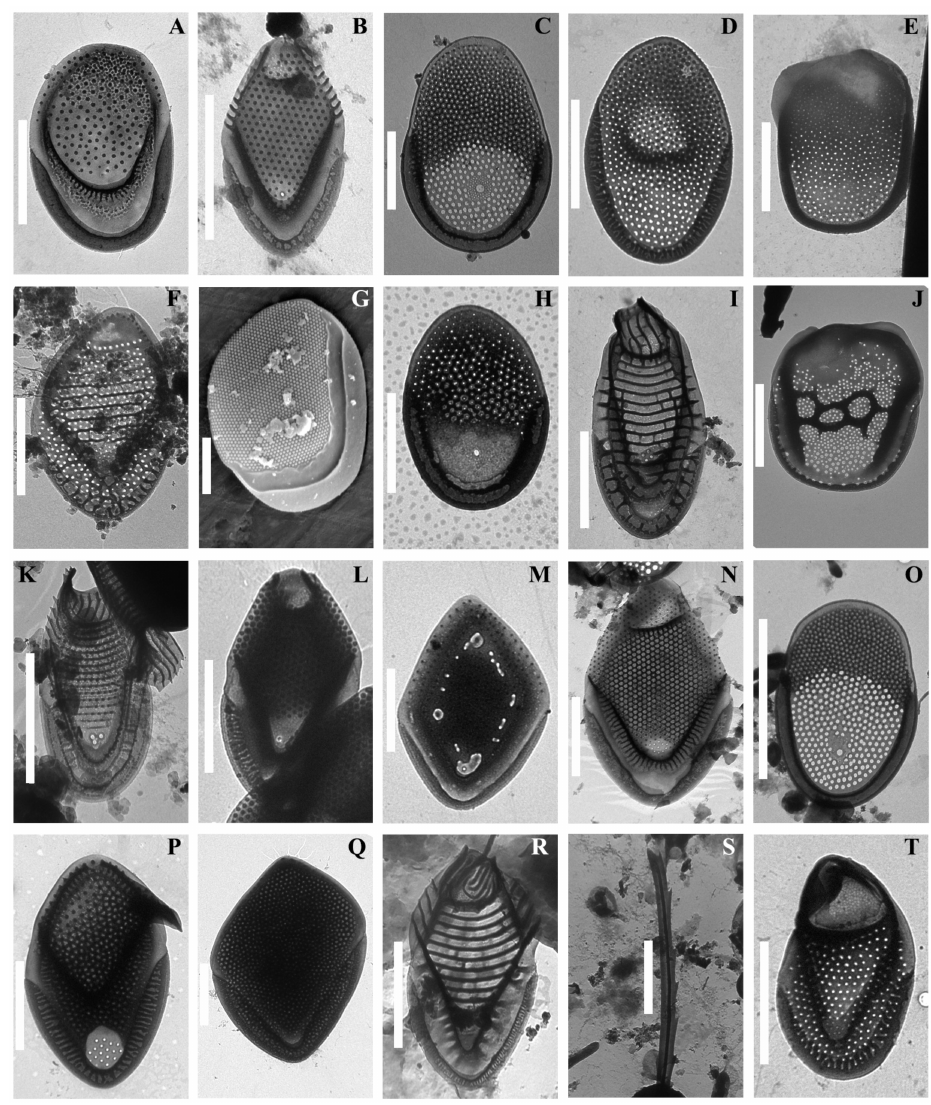
Figure 4. Scales and bristles of Mallomonas . ( A ) M. cf. ouradion . ( B ) M. papillosa . ( C ) M. paragrandis . ( D ) M. peronoides . ( E ) M. plumosa . ( F ) M. portae-ferreae . ( G ) M. pseudobronchartiana . ( H ) M. pseudo- matvienkoae . ( I ) M. pseudocratis . ( J ) M. punctifera . ( K ) M. punctostriata . ( L ) M. rasilis . ( M ) M. siderea . ( N ) M. cf. skvortsovii . ( O ) M. sorohexareticulata . ( P ) M. spinosa . ( Q ) M. splendens . ( R , S ) M. striata var. serrata . ( T ) M. tonsurata . Scale bars: 0: 5 µ m; ( A – L , N , P – T ): 2 µ m; ( M ): 1 µ m. TEM: ( A – F , H – T ); SEM: ( G